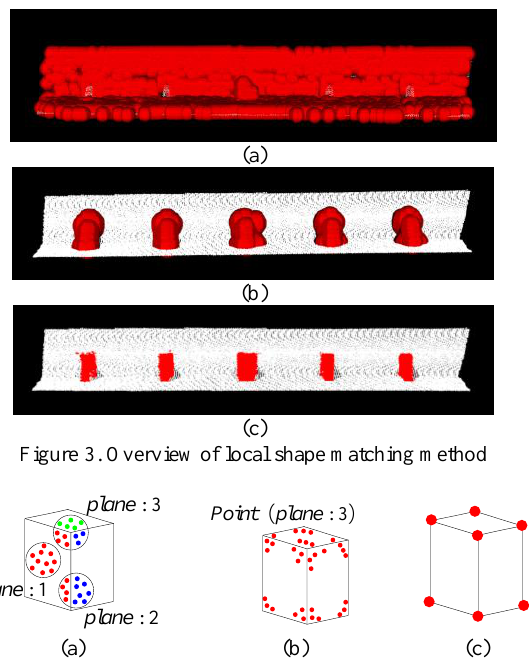
Figure 4 Overview of searching keypoints method